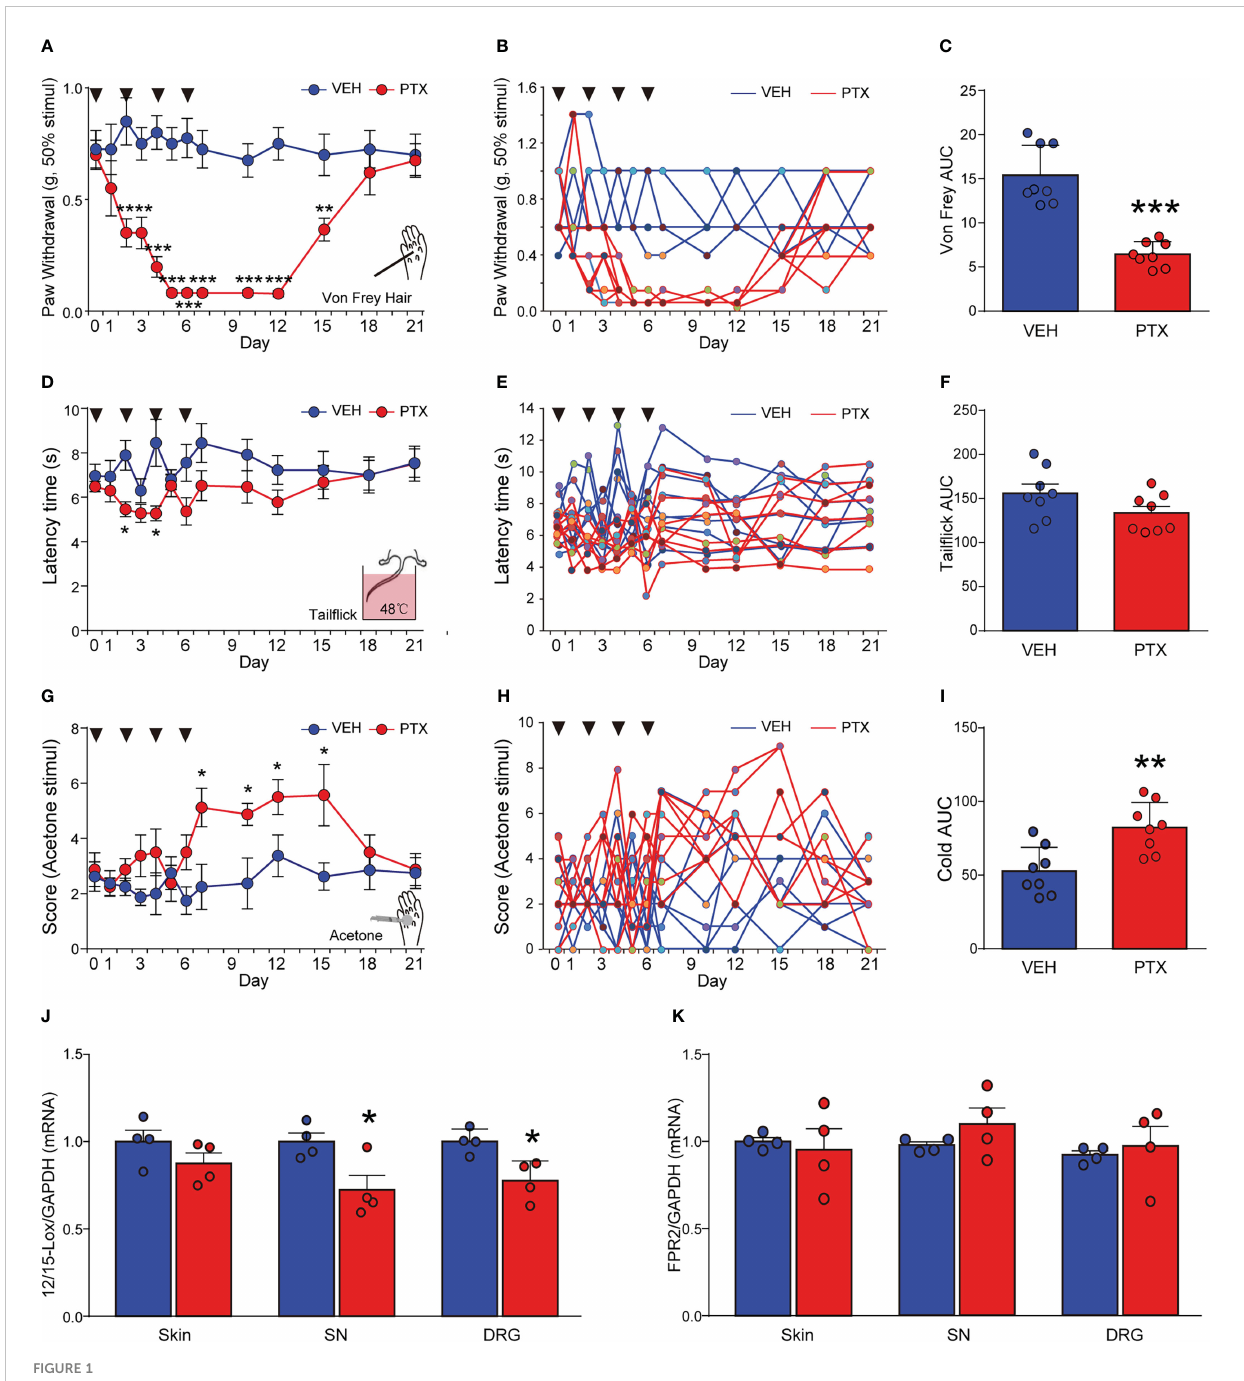
FIGURE 1 Paclitaxel induced peripheral neuropathic pain in mice, and decreased 12/15-Lox expression. PTX was injected intraperiotoneally (i.p) in mice at a dose of 2 mg/kg on days 0, 2, 4 and 6 to generate PTX-induced neuropathic pain. Nociceptive thresholds to mechanical (A) , heat (D) and cold (G) stimulation of the hindpaws of mice (**** means ** Day 2 and Day 3 vs VEH, ****** means *** Day 5, 7, 10, 12 vs VEH). Individual mouse time course plots showing changes in mechanical (B) , heat (E) , and cold (H) . Area under the time course cures (AUC) of mechanical (C) , heat (F) , and cold (I) thresholds. 12/15-Lox (J) and FPR2 (K) mRNAs in DRG, SN, skin tissues were determined by qPCR. *p < 0.05, **p < 0.01, ***p < 0.001 vs VEH group, n=8 (A – I) , n=4 (J, K) . PTX, paclitaxel; VEH, vehicle; AUC, area under